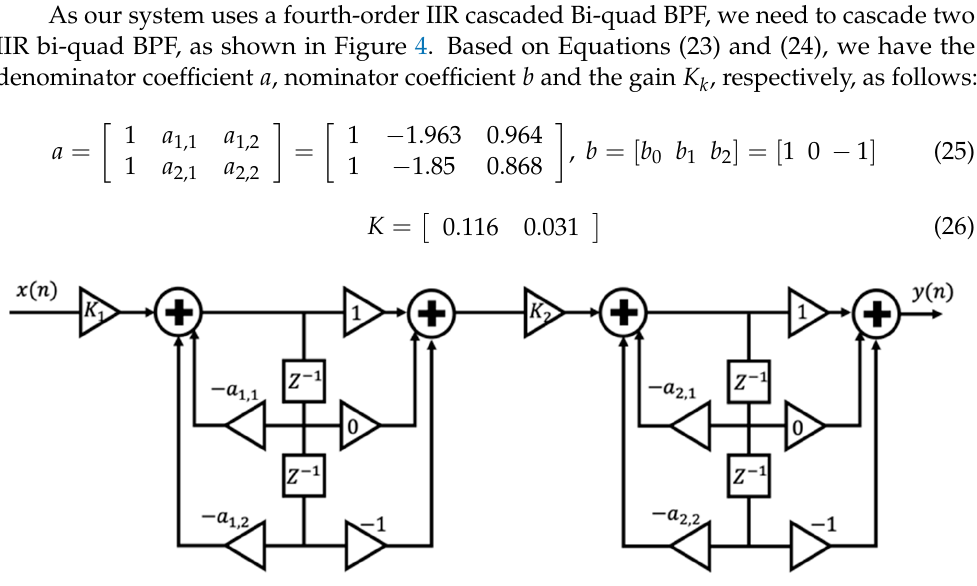
Figure 4. Fourth order of IIR BPF using cascaded bi-quad.